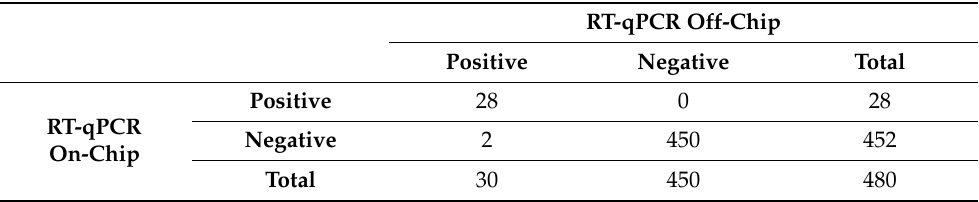
Table 5. Summary of testing results of 40 clinical samples by RT-qPCR in both off-chip and on- chip mode.